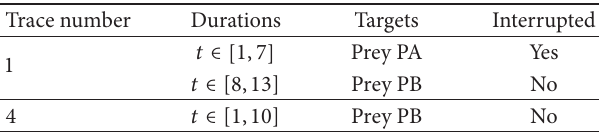
Table 1: The details of two